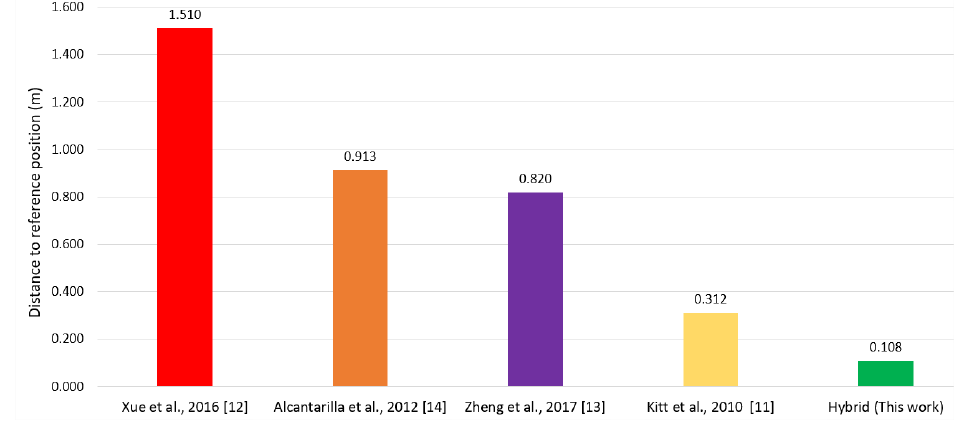
Figure 17. Comparison of the margin of error of the hybrid model and the related works.